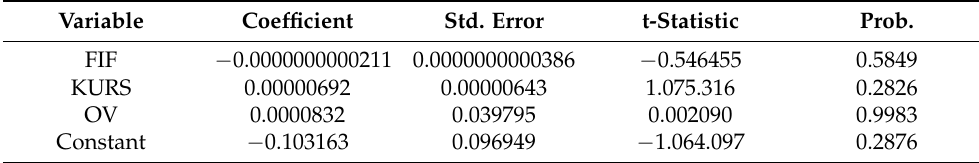
Table 18. Heteroscedasticity